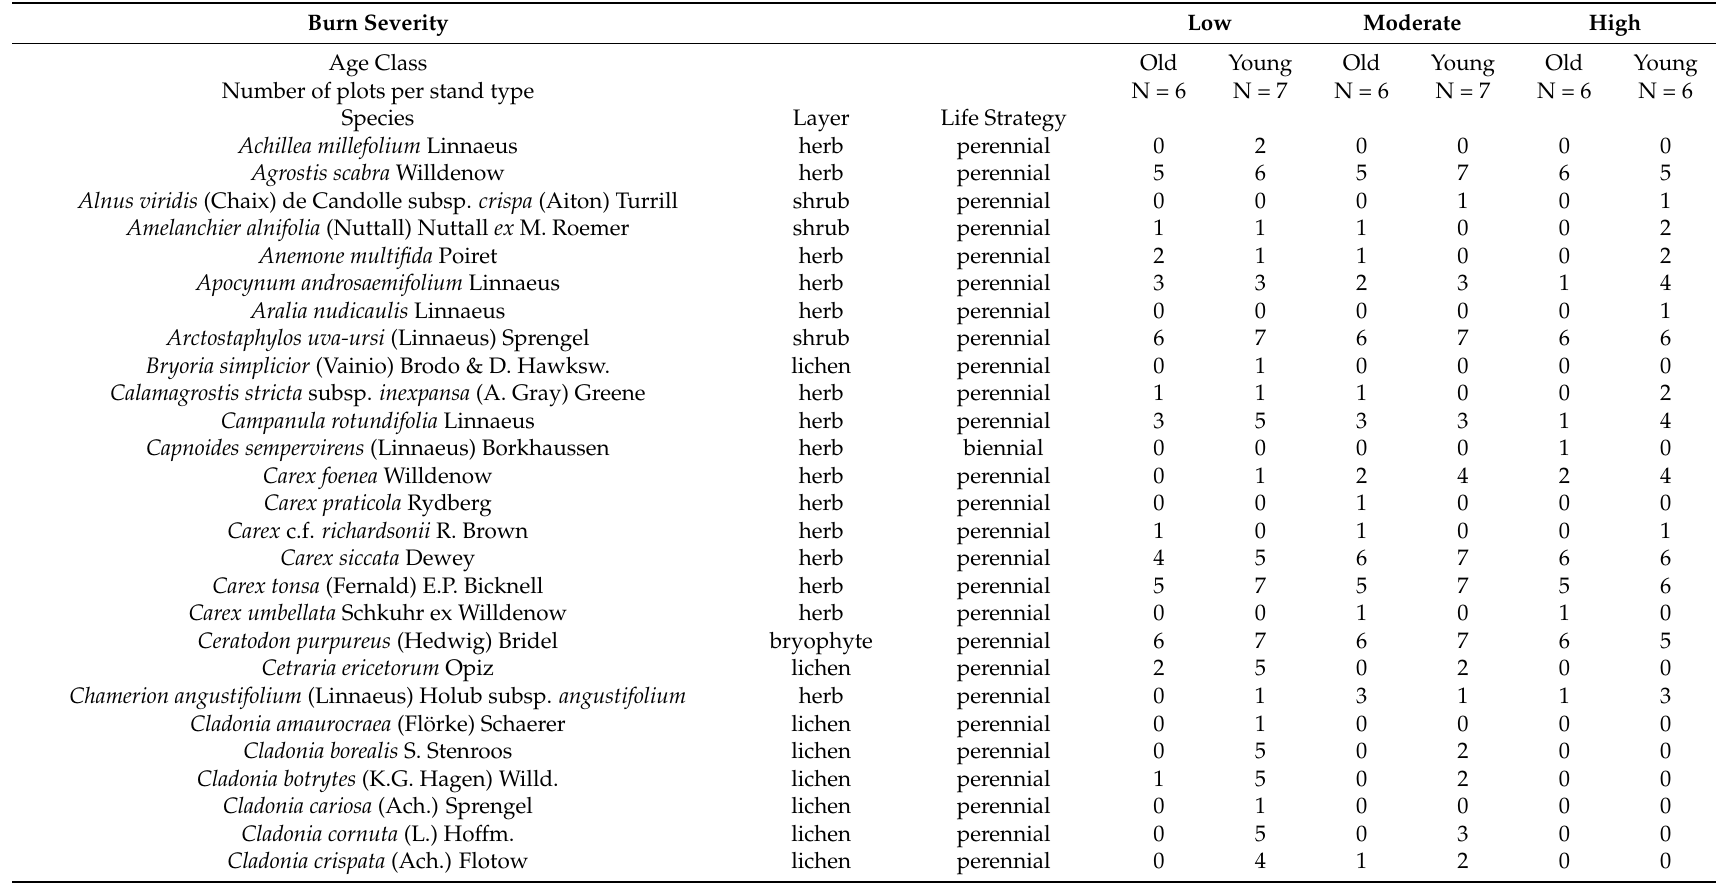
Table A1. Complete species list with the number of stands the species was found in grouped according to burn severity and pre-fire age class. Burn Severity Low Moderate High Age Class